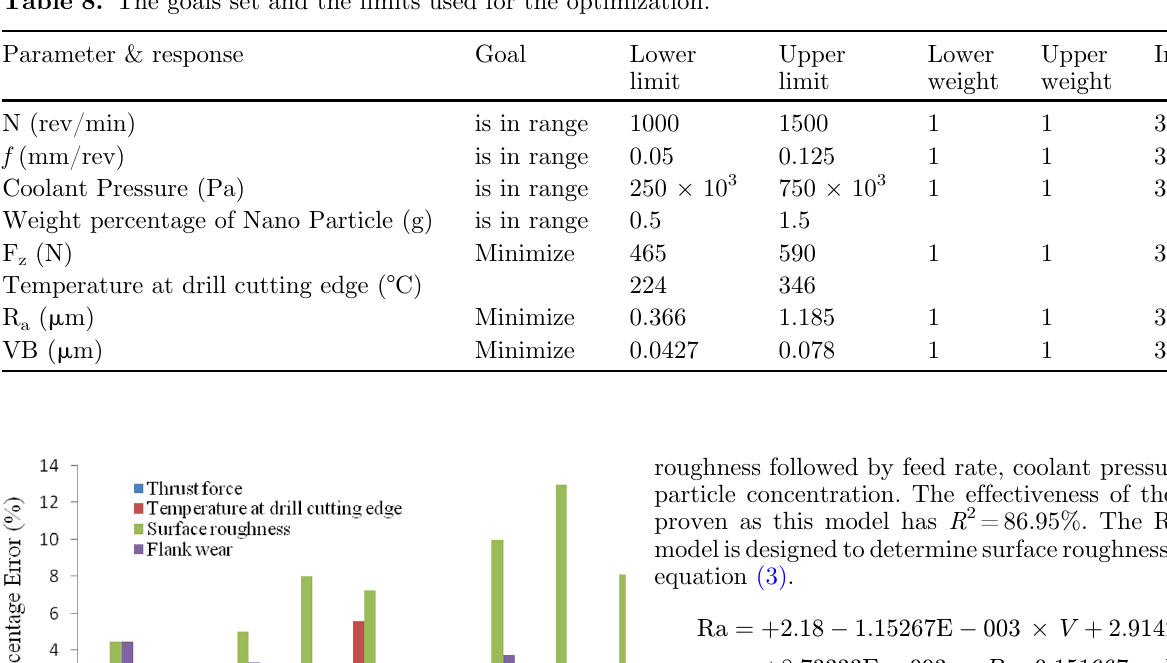
Table 8. The goals set and the limits used for the